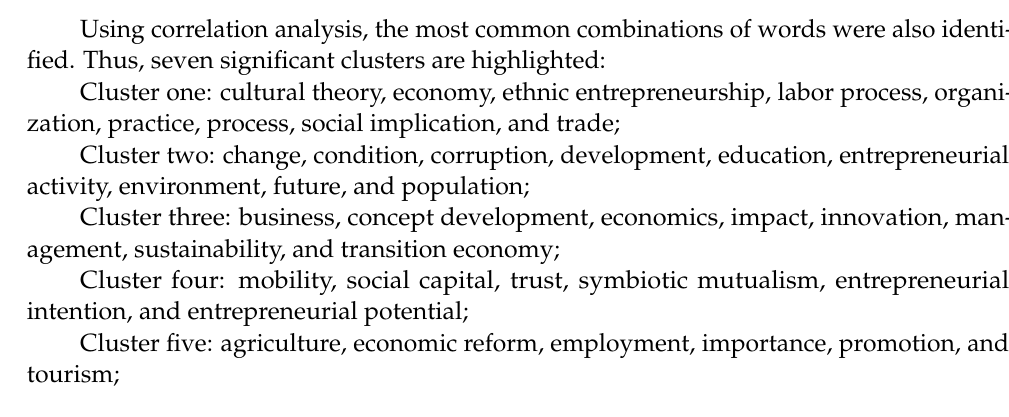
Figure 2. Most encountered words and word networks in scientific publications’ content.